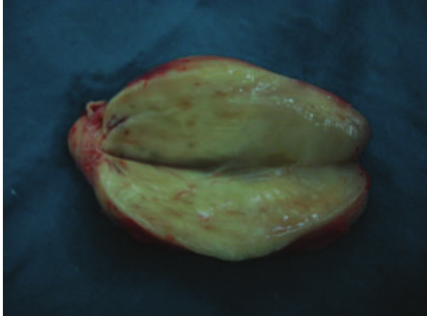
Figure 3: Cross-sectional image of the excised